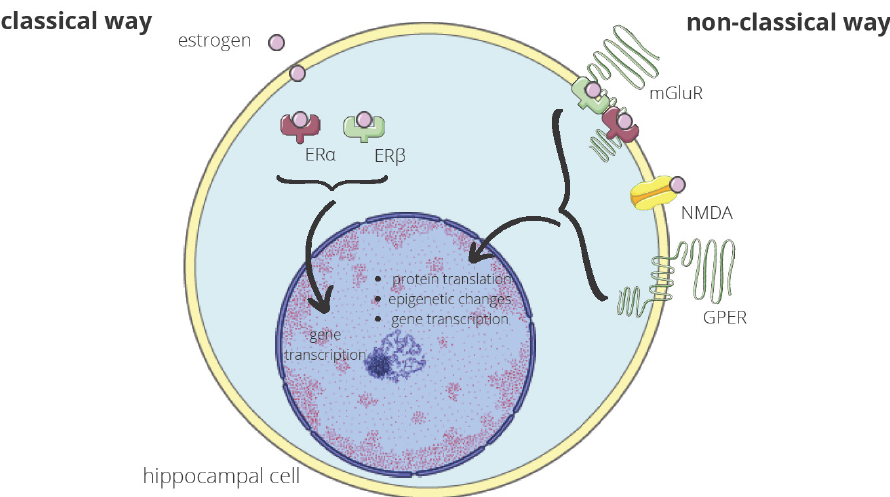
Figure 2. Effect of estrogen on hippocampal cells. Estrogen interacts with the hippocampal cells through a classical and non-classical way. In the classical one, estrogen binds to ER α and ER β in the cytoplasm. The estrogen-receptor complexes interact then with the genome, inducing gene transcription. The non-classical way takes place near or in the plasma membrane. Metabotropic glutamate receptor 1a (mGluR1a) is influenced by ER α and ER β with the bound estrogen, the N-methyl-D-aspartate receptor (NMDA), by estrogen alone and GPER by estrogen indirectly. The receptors induce cell signaling, resulting in protein translation, epigenetic changes, or gene expression. These molecular processes are crucial for memory formation in the hippocampus